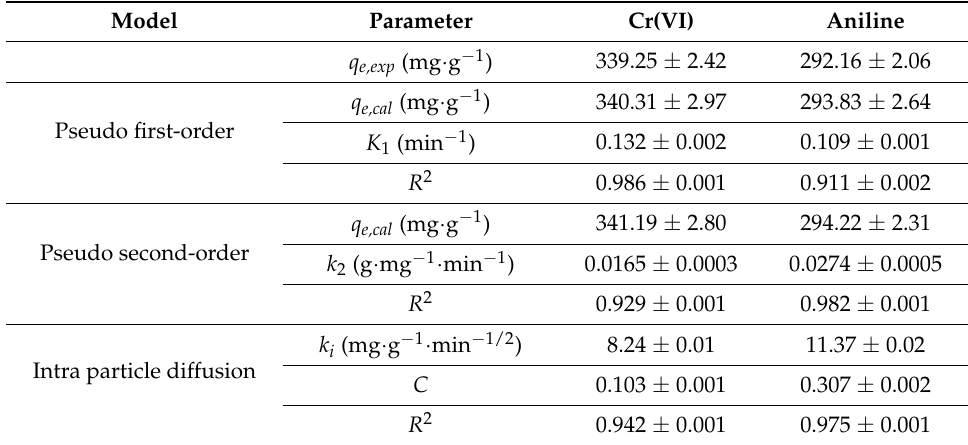
Table 2. Adsorption kinetic models using MFH at T = 298